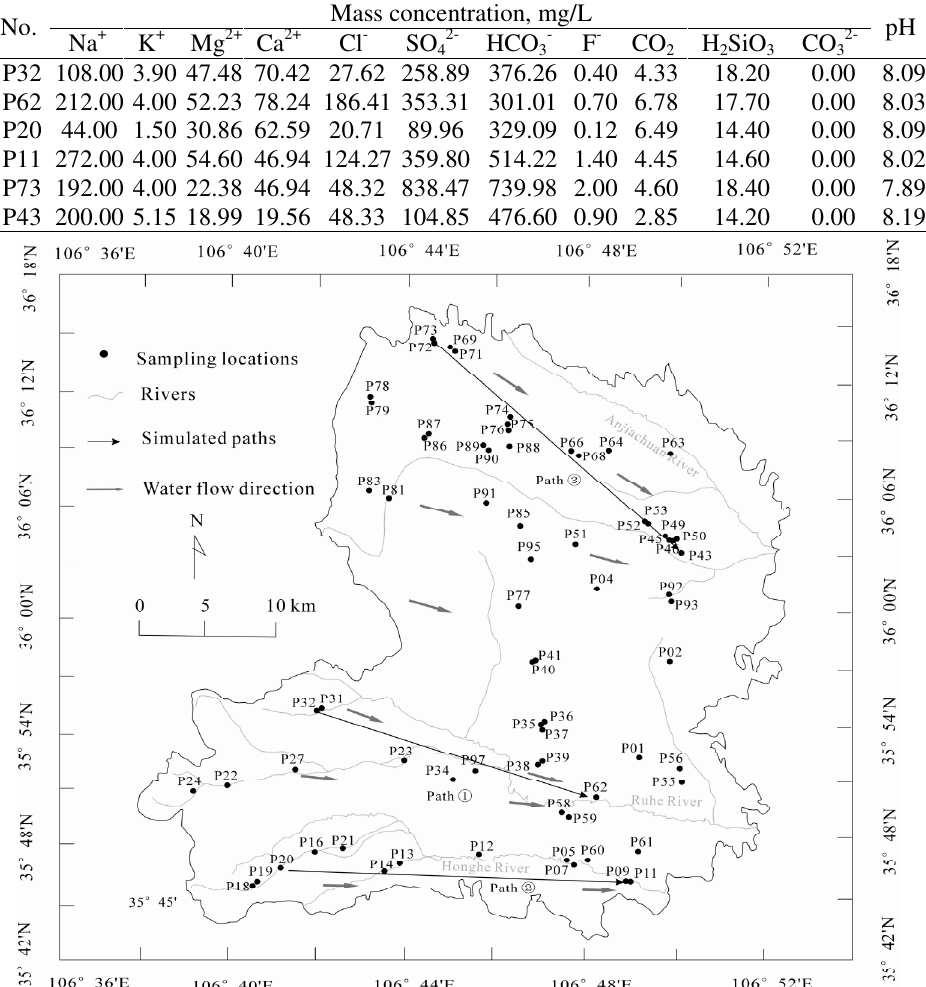
Table 1. Water quality analysis results along simulated paths